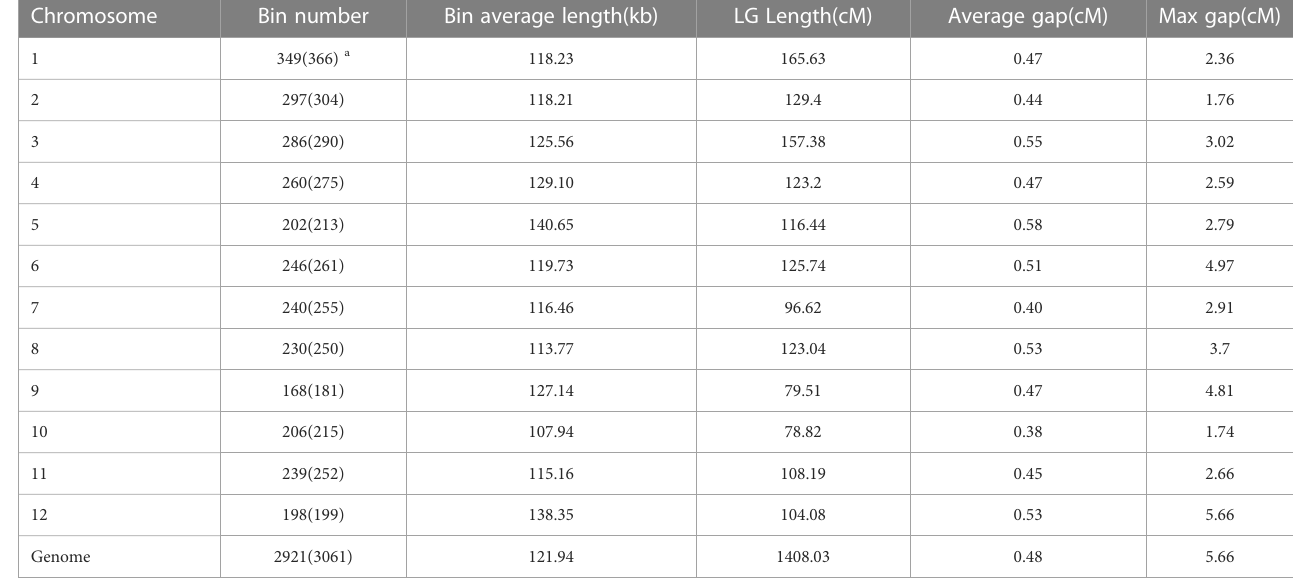
TABLE 1 Characteristics of the high-density genetic map based on bin markers.